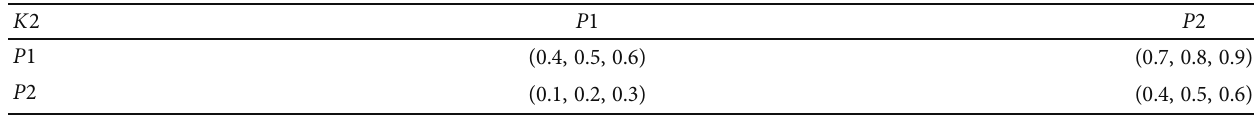
Table 7: Judgment matrix of various indicators of construction material risk.